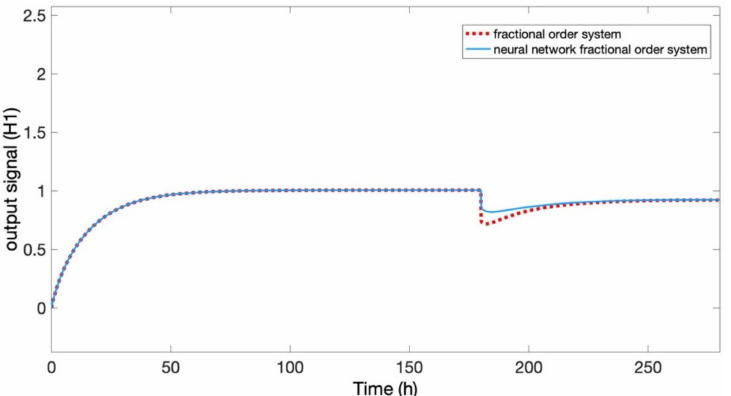
Figure 15. The proof of learning the decreasing dynamics of the fractional differentiation order (from β = 0.91 to β = 0.82 at t = 180 ( h )